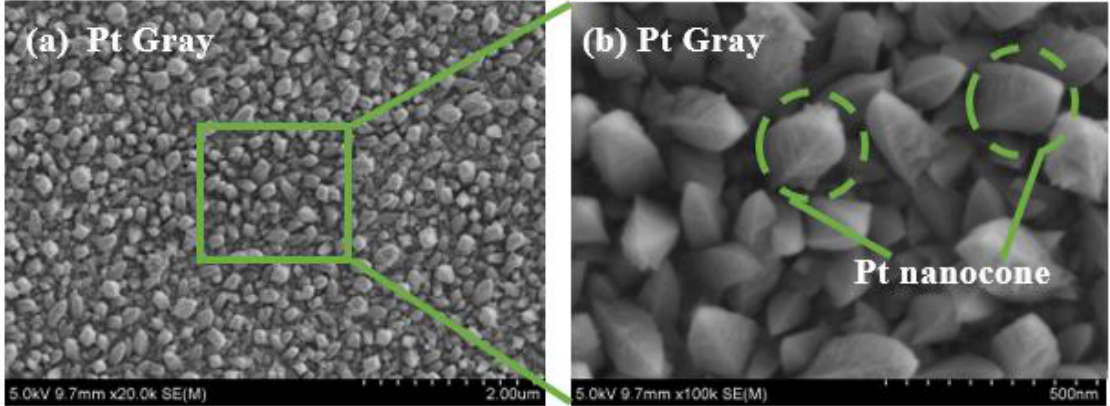
Figure 5. SEM of Pt-gray and porous surface ( a , b ) created for nanocone